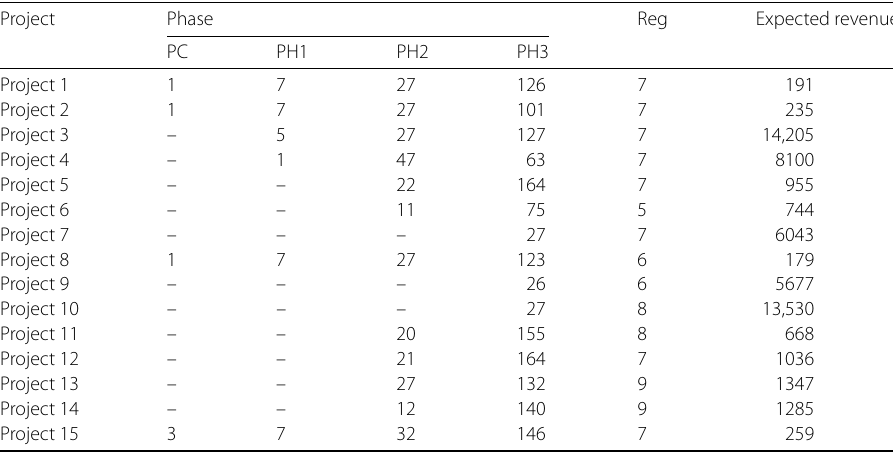
Table 1 Expected cost and expected revenue of each project ($